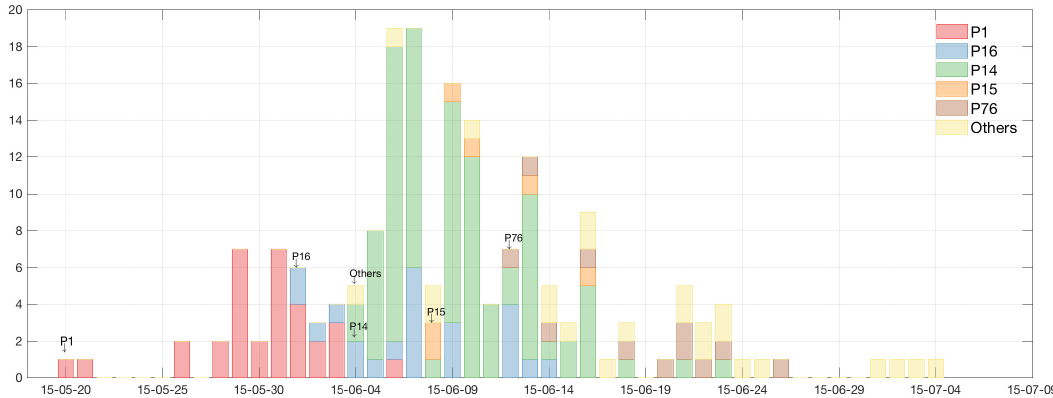
Figure 1. Time series of 2015 MERS-CoV cases is displayed and classified by five super-spreaders: these five colors represent the cases by each super-spreader (yellow color is unknown due to multiple contacts). At the beginning of the epidemic, the red bar indicates secondary cases by the index case ( P 1 ). This shows significant heterogeneity in the 2015 MERS-CoV transmission: five super-spreaders (3%) infected 79% (147/186) of the total MERS-CoV